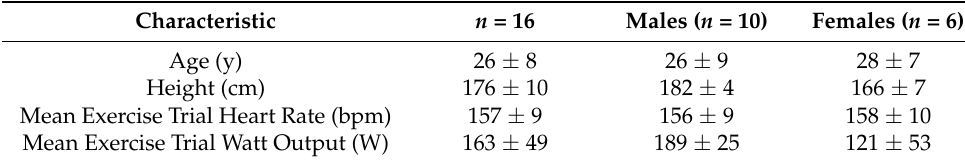
Table 1. Participant Characteristics.